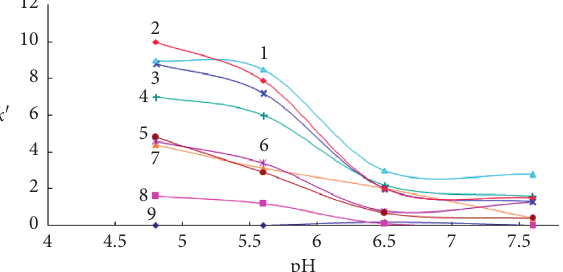
Figure 5: Effect of pH on the retention of PA on SP-2. Acids (100 μ g/ml):1, caffeic; 2, ferulic; 3, p -coumaric; 4, sinapic; 5, vanillic; 6, gallic; 7, salicylic; 8, sorbic; 9,